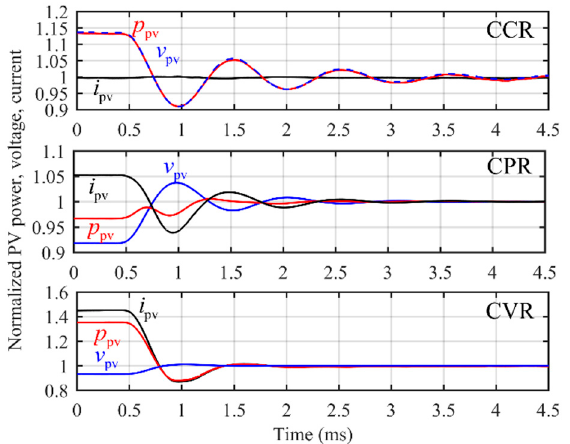
Figure 6. Experimental behavior of PVG voltage (blue), current (black), and power (red) when a step change in the duty ratio of a boost-power-stage converter is applied in different PVG operational regions. All the waveforms are normalized in terms of their final values .